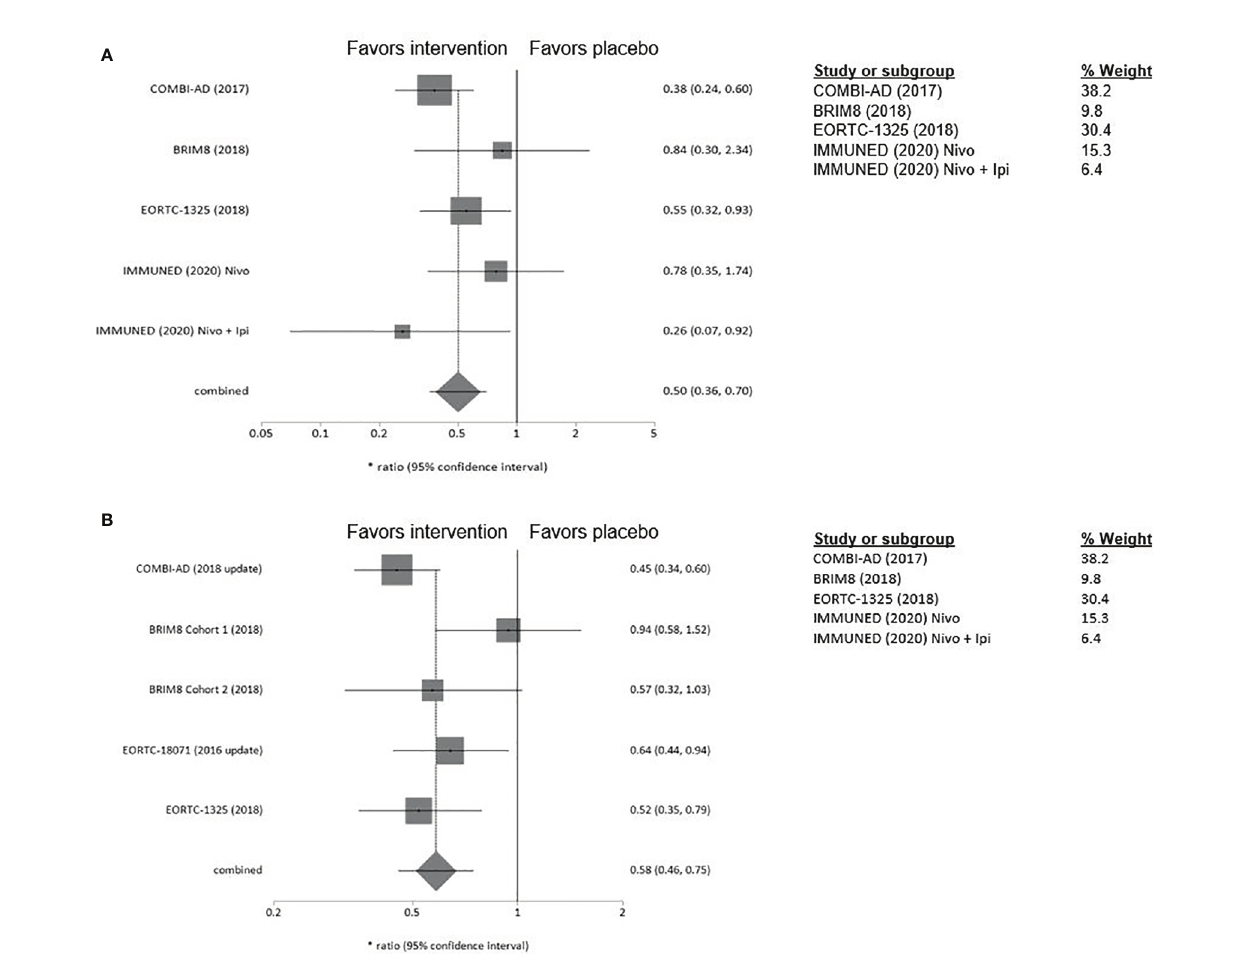
FIGURE 3 | (A) Forest plot for primary outcome analysis on relapse free survival for patients ≥ 65 years old . (B) Forest plot for primary outcome analysis on survival for patients < 65 years old . Notes: Hazard ratio for relapse or death along the x-axis, and results from the different studies, with gray squares representing effect estimates and lines through them representing 95% CIs. The gray diamond represents the overall effect measure which lies clear off the line of no effect, showing a bene fi t for the treatment groups compared to placebo. The percentage weight for each study is separately listed on the right of the graph. CI, con fi dence